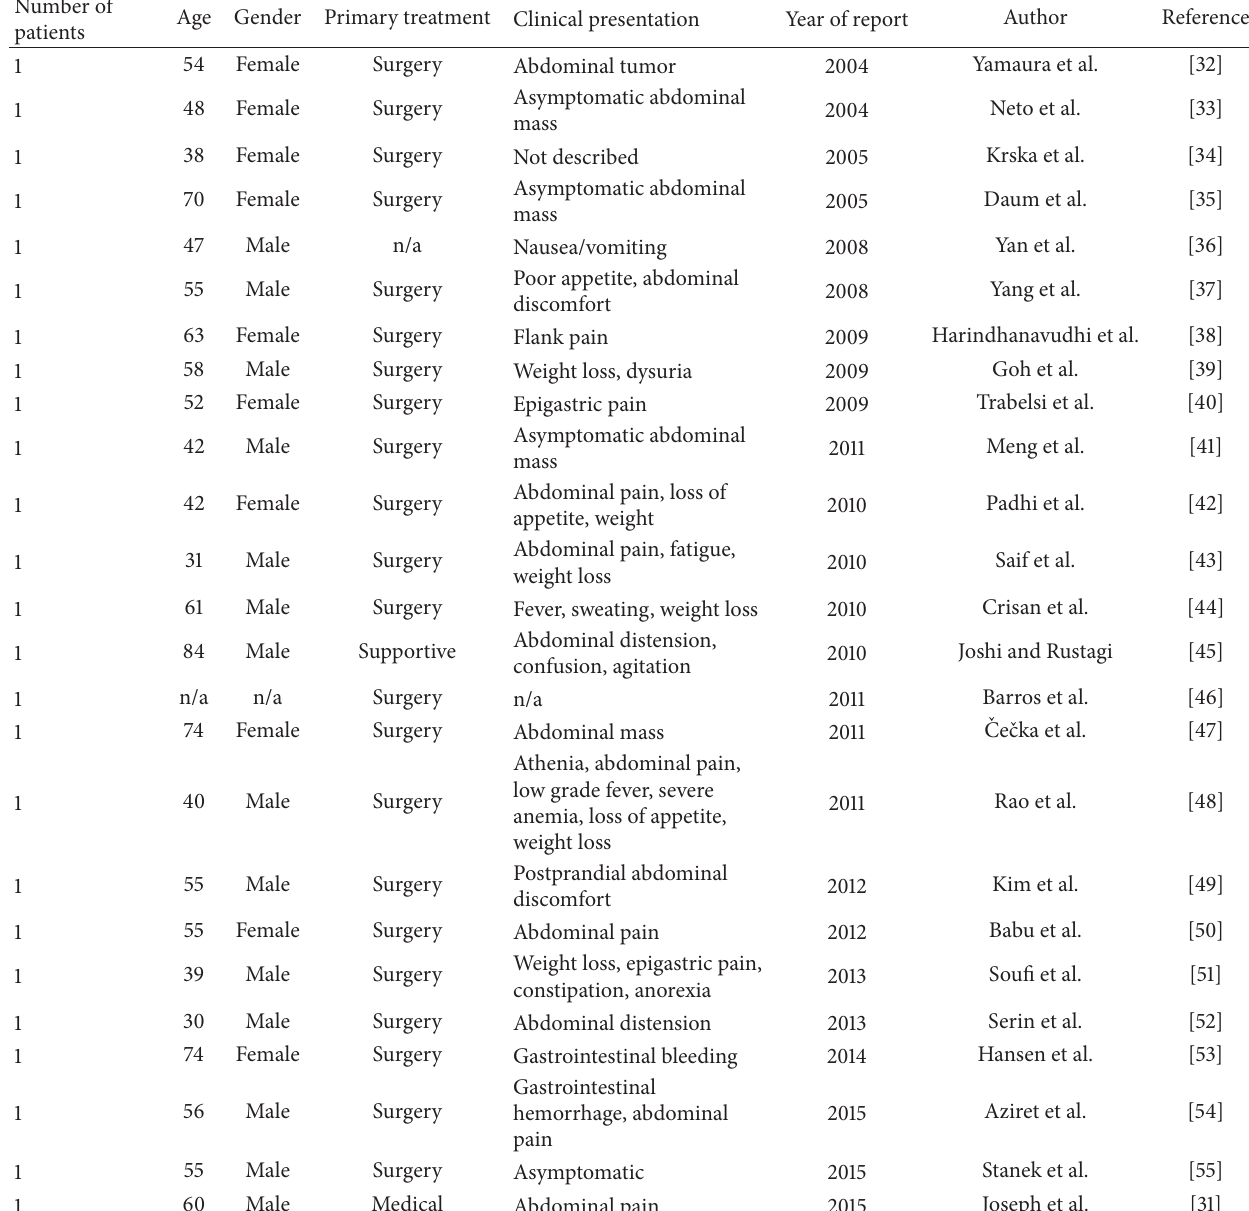
Table 2: List of published cases in English literature of pancreatic GIST. Number of